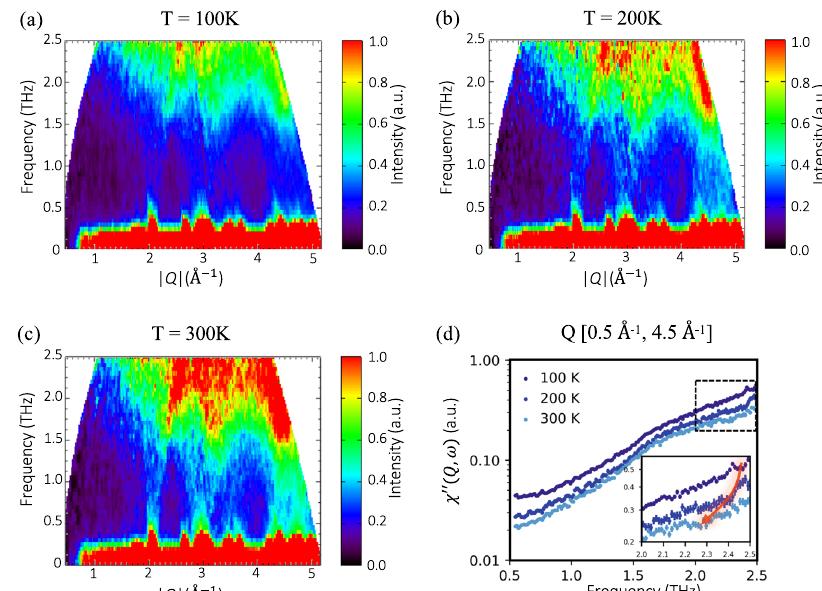
Fig. 4 Temperature dependence of the phonon spectra obtained from INS measurements. Contour plots of GeTe obtained in INS measurements on powder GeTe samples with E i = 16.9 meV at ( a ) 100 K, ( b) 200 K, and ( c ) 300 K. ( d) The imaginary part of the dynamic susceptibility on a logarithmic-scale obtained from the measured INS spectra at different temperatures. The inset shows the imaginary dynamic susceptibility at a frequency range of 2.0 – 2.5 THz.